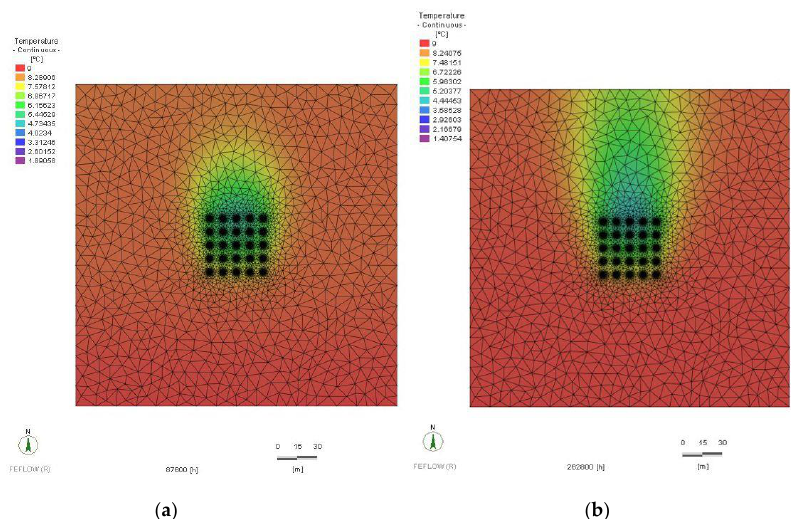
Figure 9. Results of the simulation of ground temperature after 10 years ( a ) and 30 years ( b ) of heat pump operation within the 2nd scenario (homogeneous model). Two-dimensional view of the surface at a depth of 50 m.